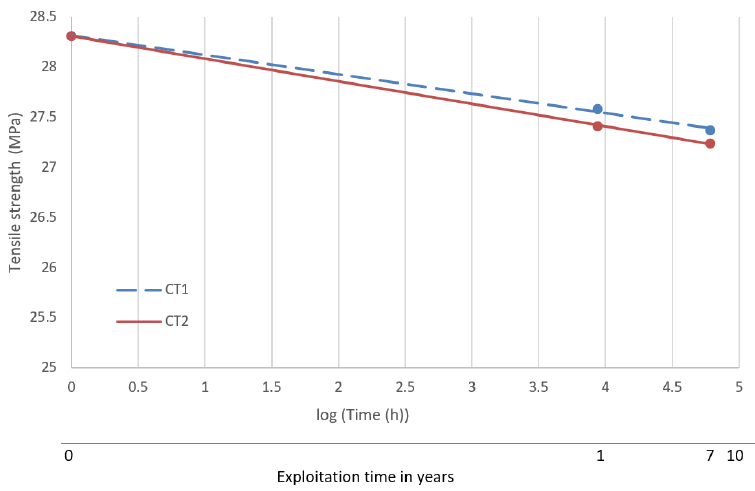
Figure 17. Relationship between tensile strength and operation time for cooling towers 1 and 2.